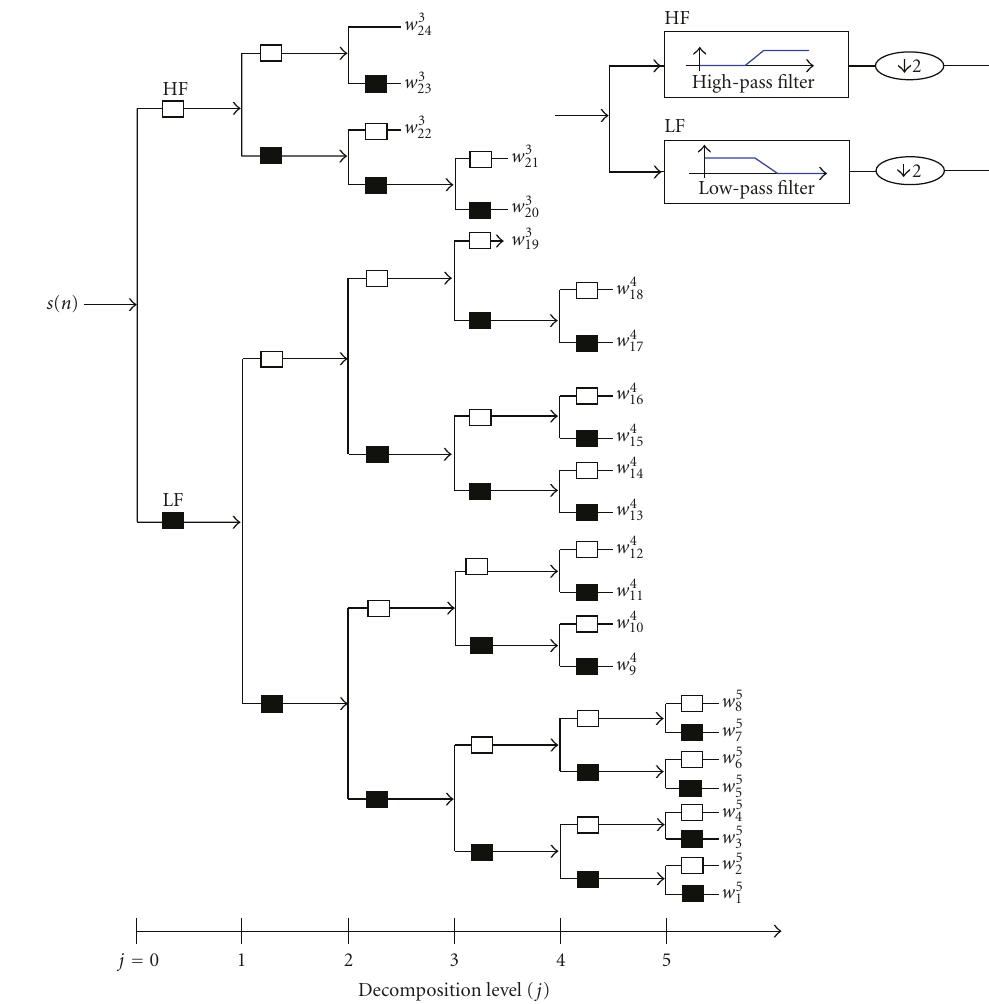
Figure 2: The structure of wavelet packet transform (PWPT).